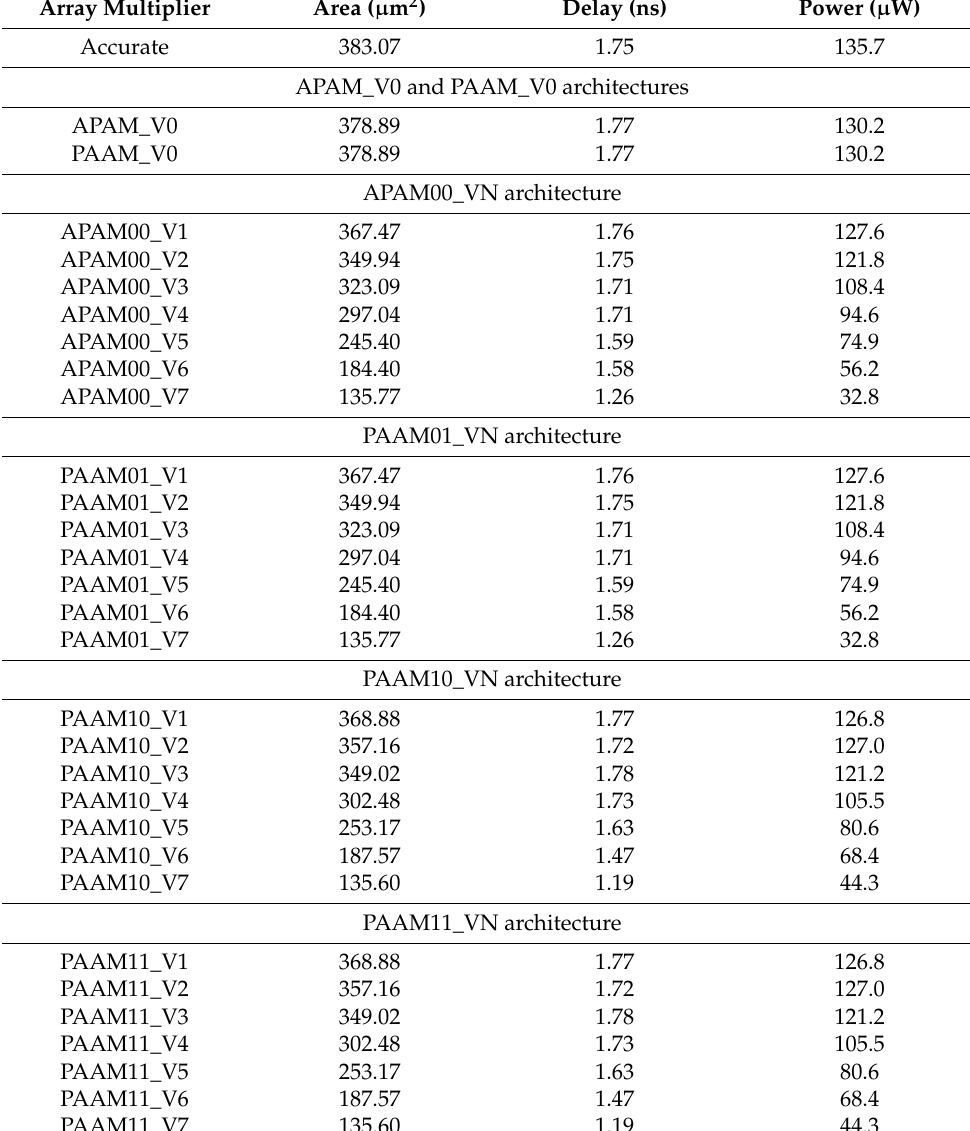
Table 2. Design metrics of accurate and approximate array multipliers, estimated using a 32/28-nm complementary metal-oxide-semiconductor (CMOS)